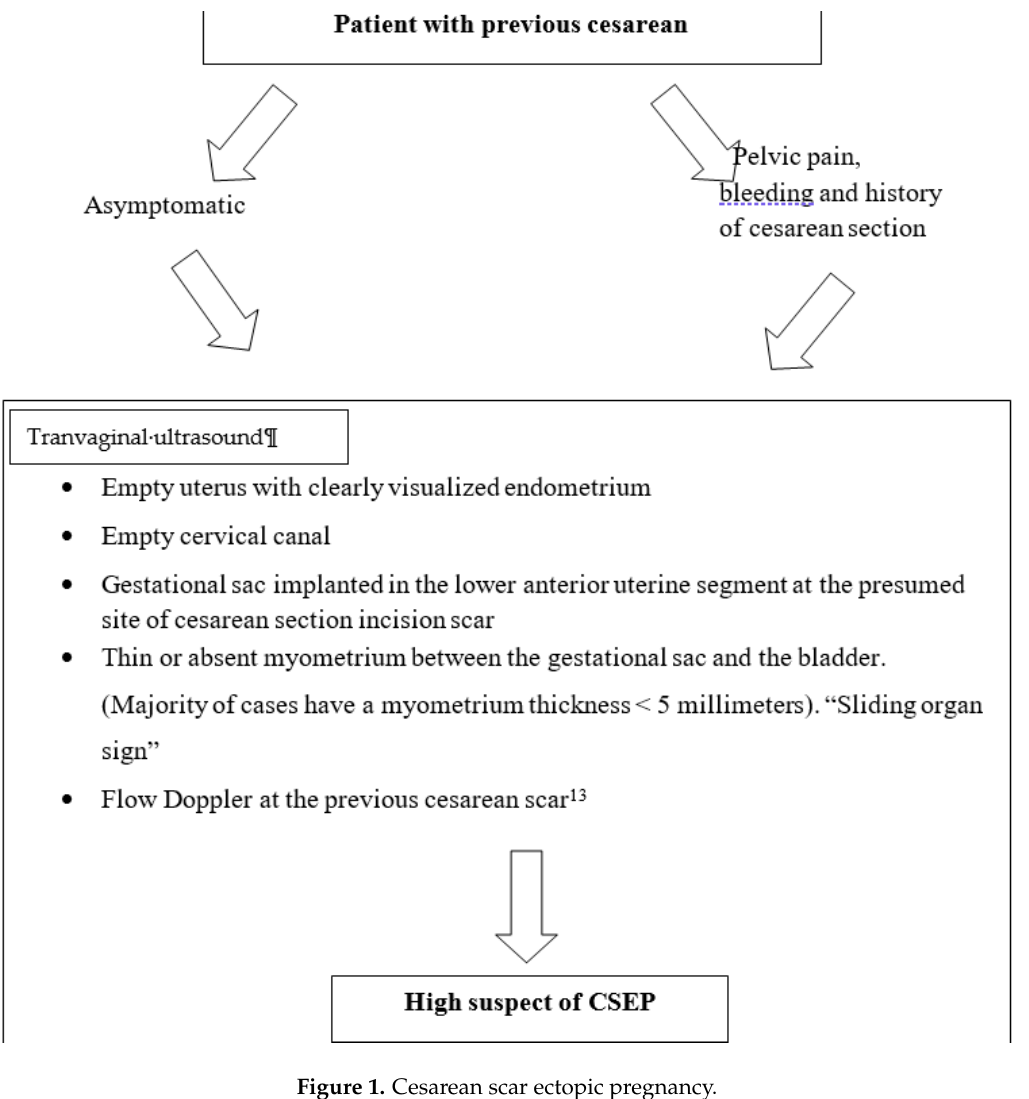
Figure 1. Cesarean scar ectopic pregnancy